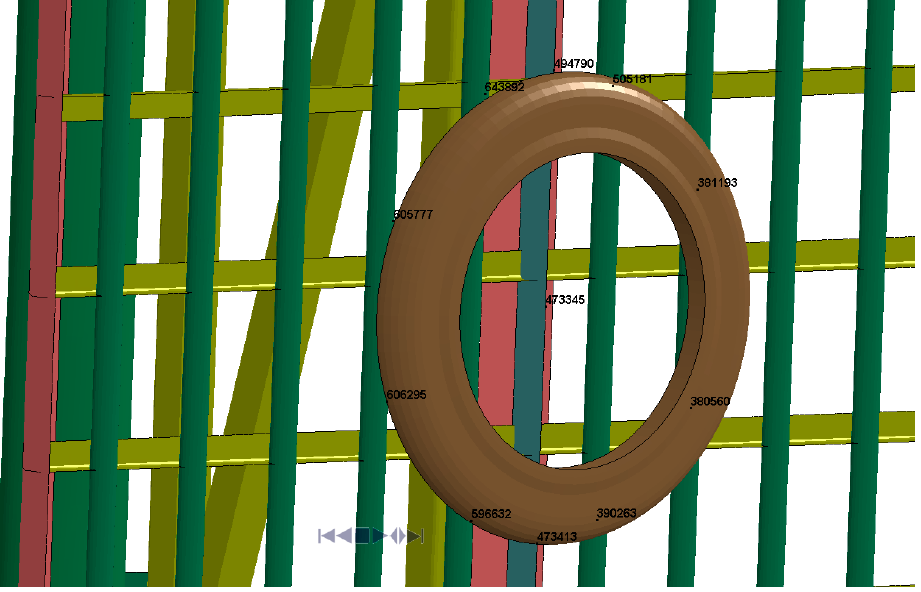
Figure 7. Selected points of the shield after an impact on the shield.